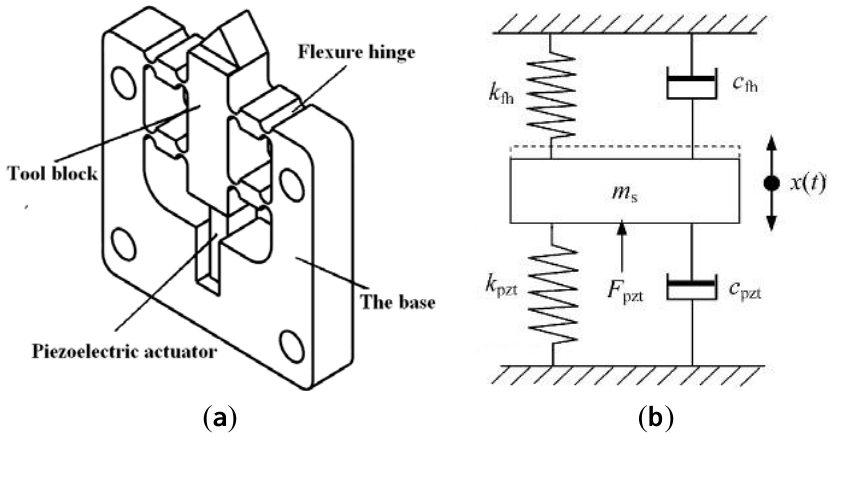
Figure 1. The schematic diagram of FTS structure and its equivalent dynamic model: ( a ) The schematic diagram of FTS structure; ( b ) The equivalent dynamics